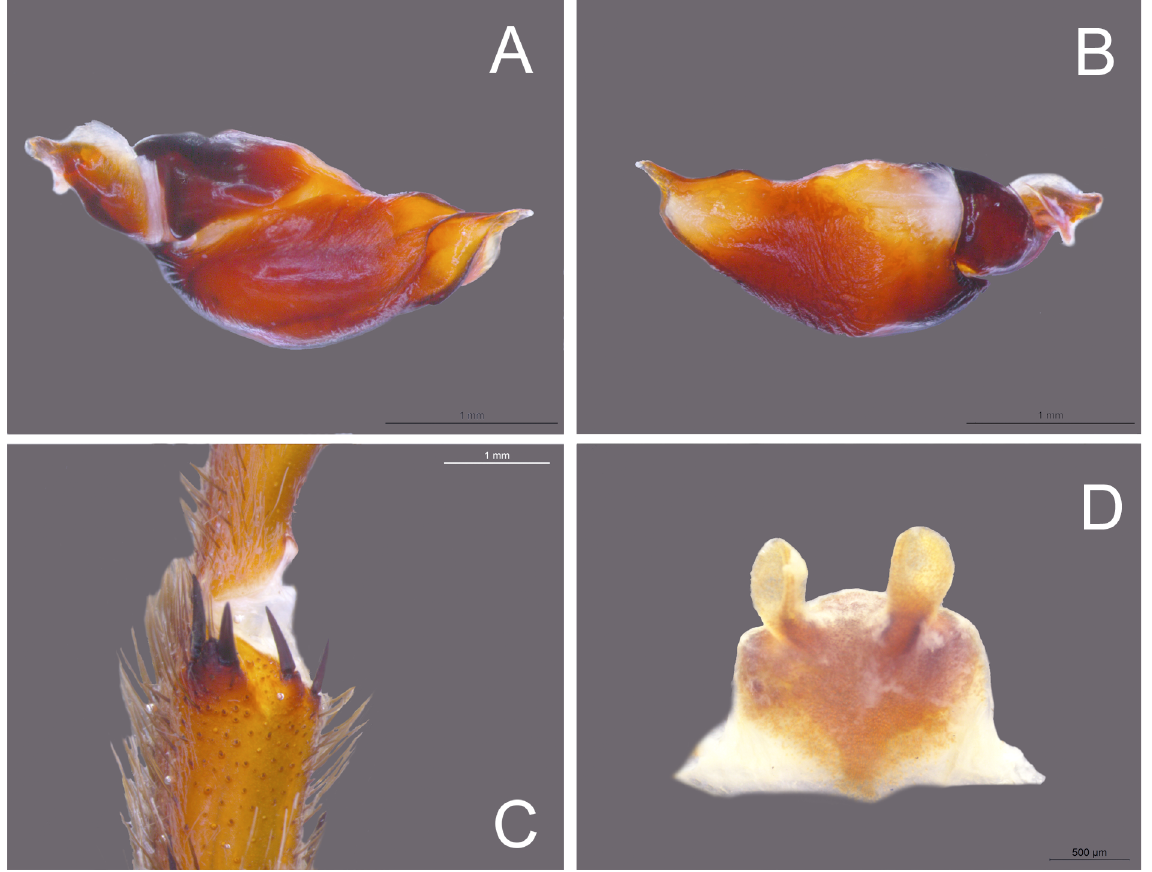
Fig. 13. Umbyquyra schmidti (Rudloff, 1996) gen. et comb. nov. A–C . ♂, Cuiabá, Mato Grosso, Brazil (IBSP 110728). A . Palp prolateral. B . Retrolateral. C . Tibial apophysis, retrolateral. D . ♀, spermathecae, dorsal (IBSP